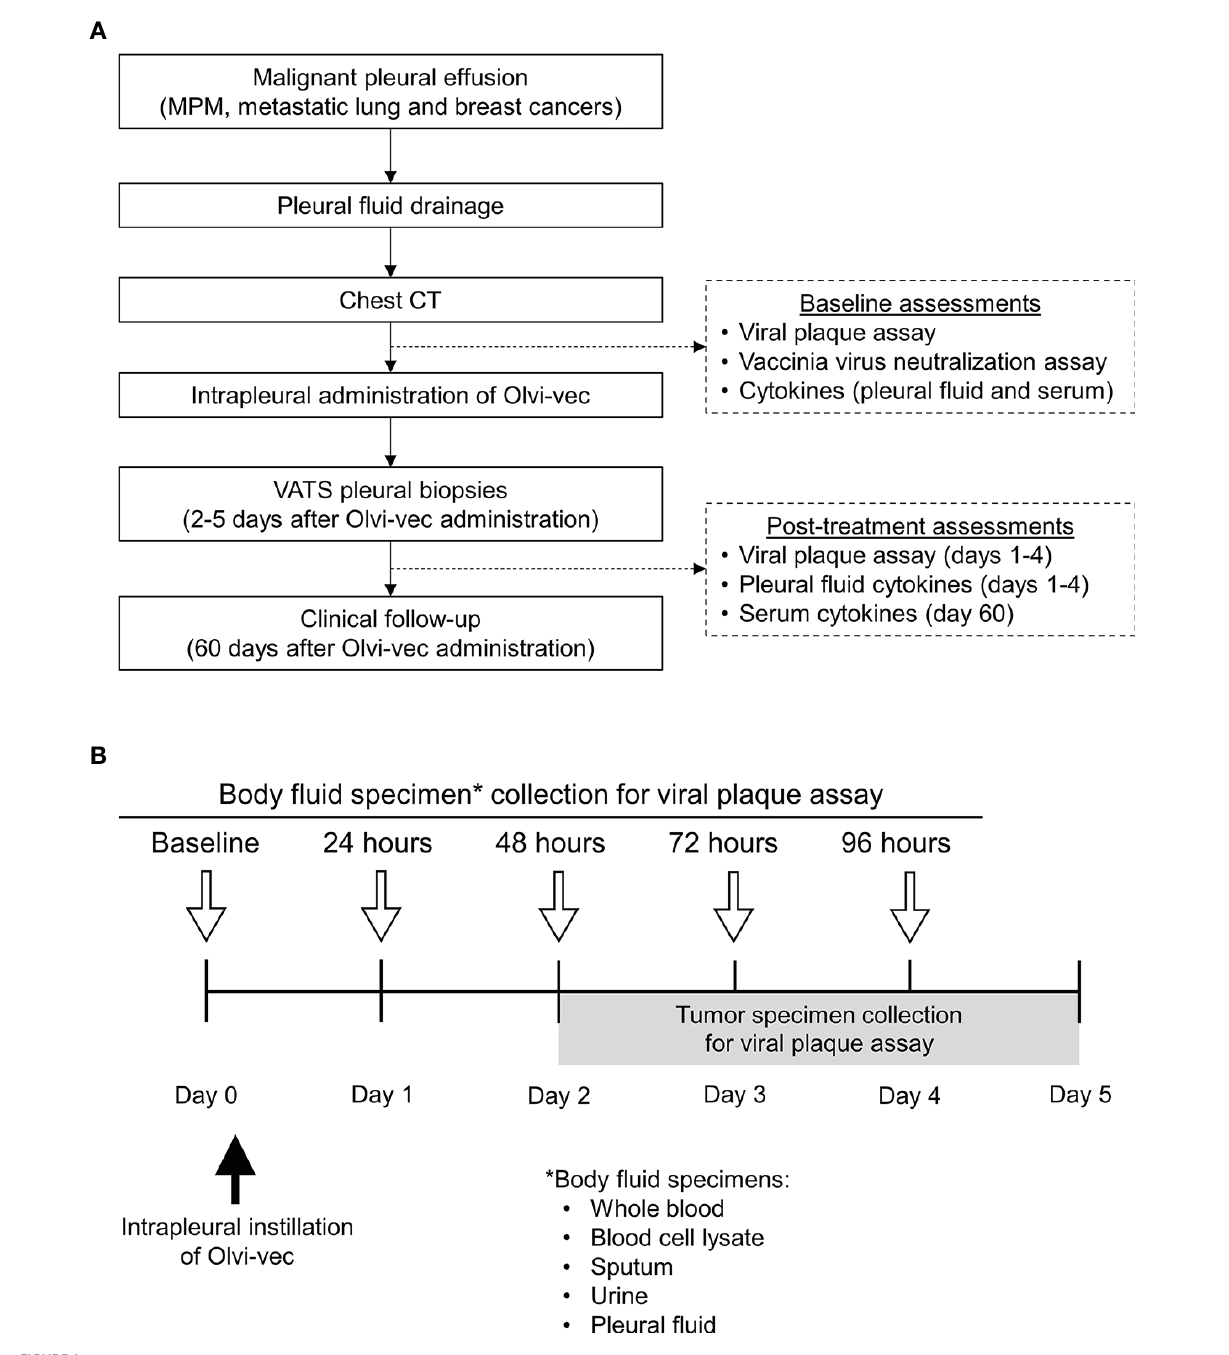
FIGURE 1 Protocol schema (A) and specimen collection schema for viral plaque assay (B) . *List of specimens